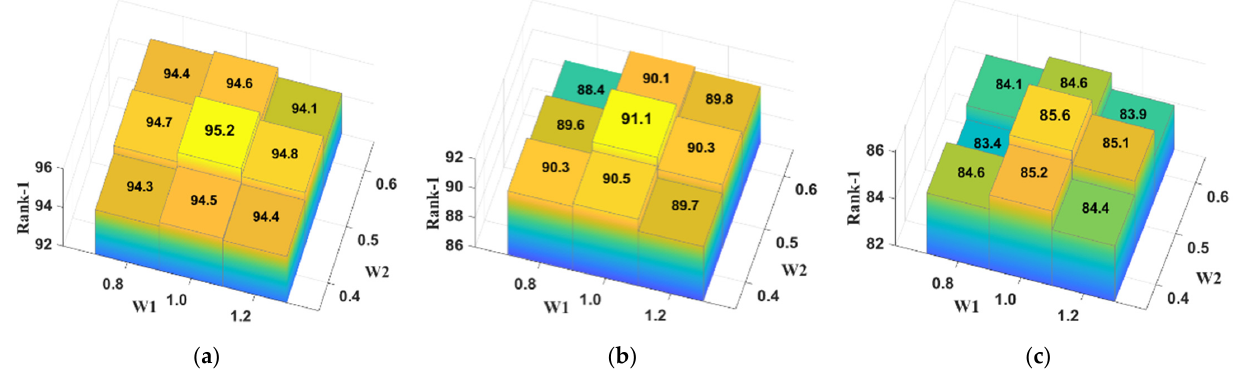
Figure 3. Optimization of AML baseline loss functions on three datasets: ( a ) the Market-1501 dataset; ( b ) the DukeMTMC-ReID dataset; ( c ) the CUHK-03 (detected) dataset. Coefficient 𝑤 (cid:2869) and 𝑤 (cid:2870) : In the loss function part, it is found that different combina- tions of coefficients have a great influence on the experimental results. Therefore, we need to adjust the coefficient of triplet loss and AML loss appropriately. We set the initial values to 𝑤 (cid:2869) = 0.5 and 𝑤 (cid:2870) = 0.5 and obtain the final parameter values by using this control var- iable method [26].